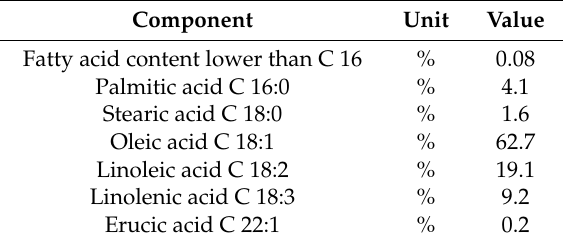
Table 3. The components of rapeseed oil—used for the further preparation of an electro-insulating liquid.